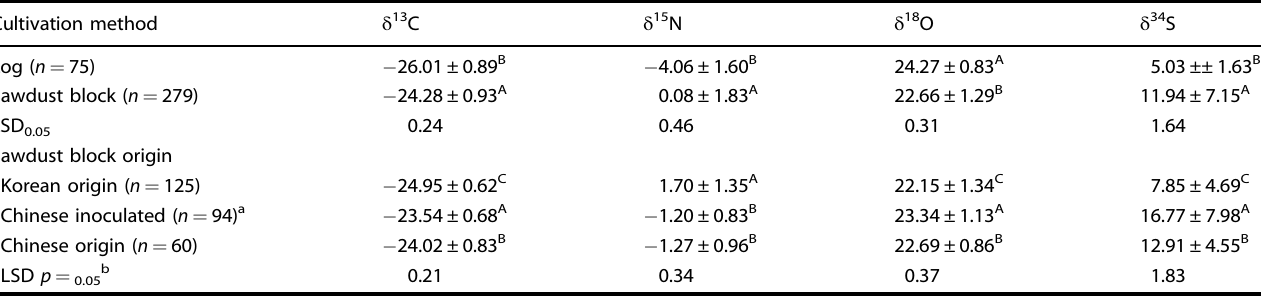
Table 1. Differences in stable isotope ratios ( δ 13 C, δ 15 N, δ 18 O, δ 34 S) in shiitake mushrooms according to the geographical origin of the sawdust blocks and cultivation method (log versus sawdust block).